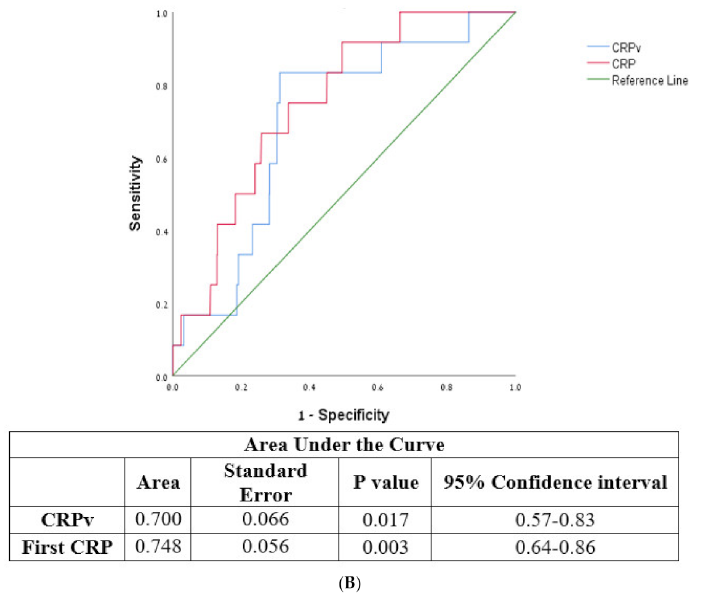
Figure 3. ( A ) Receiver operator characteristic curve for CRPv, CRP, and severe systolic heart failure with ejection fraction <35%. CRP—C-reactive protein, CRPv—C-reactive protein velocity. ( B ) Receiver operator characteristic curve for CRPv, CRP and severe diastolic heart failure. CRP—C-reactive protein, CRPv—C-reactive protein